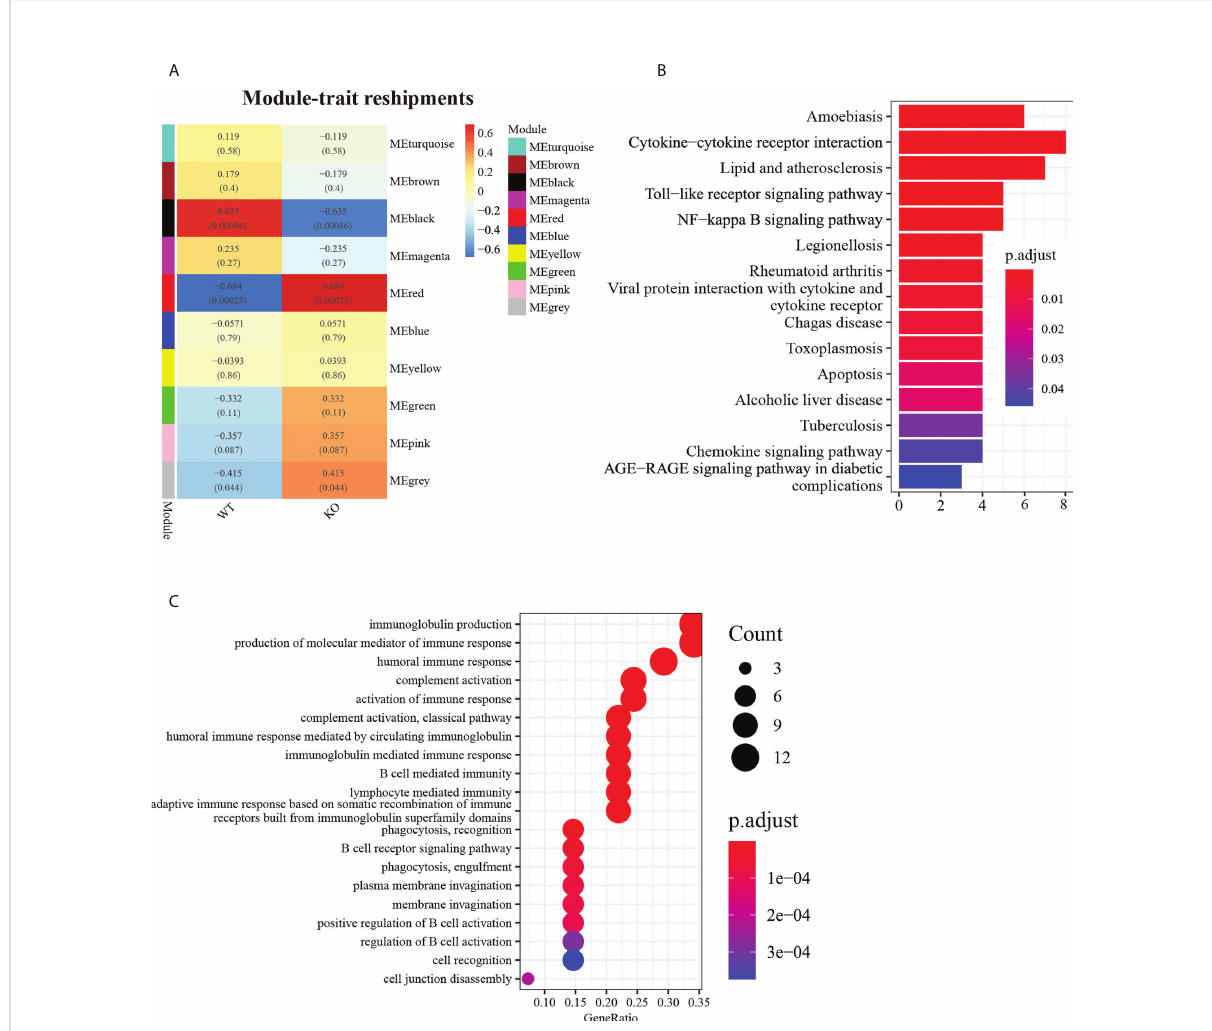
FIGURE 2 WGCNA identi fi ed gene co-expression networks in Csf2ra KO mice and WT mice. (A) Topological overlap matrix plot showing pairwise gene correlations within each module. Genes within different modules are labeled with different colors according to WGCNA ’ s conventions. (B) The top 15 KEGG entries for genes found in the “ black ” module. The x -axis represents gene count and the y -axis is KEGG terms. (C) The top 20 entries in GO analysis for biological processes in the “ red ”